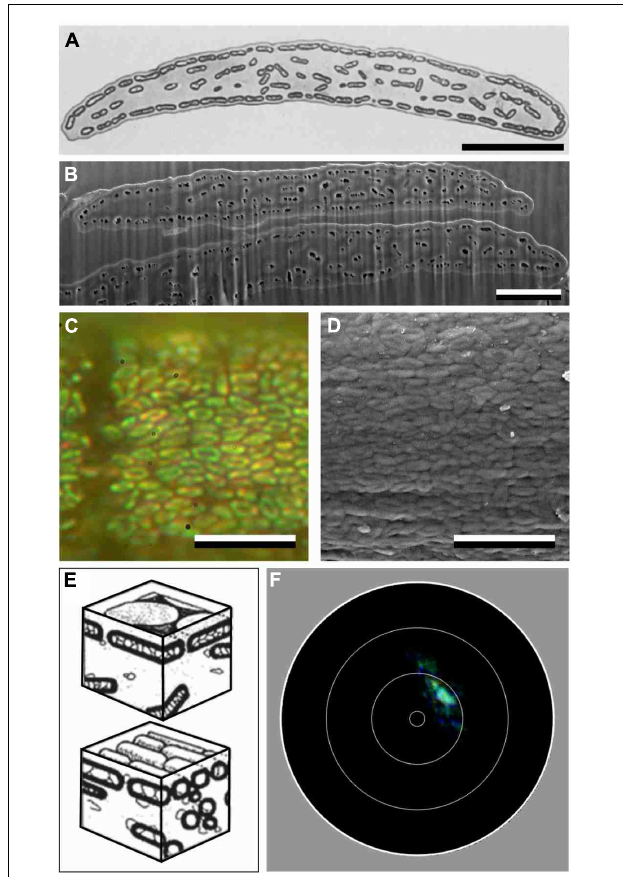
FIGURE 6 | Anatomy and scatterometry of a barbule of L. nitens . (A) Transmission electron micrograph (TEM) of a barbule cross-section of the Superb starling, Lamprotornis superbus [modified after Durrer (1977)]. (B) Scanning electron micrograph (SEM) of a cross- section of two overlapping barbules of L. nitens . Note that the contrast between TEM and SEM is reversed: melanin is dark in (A) , but it is light in (B) , while the air holes of the melanosomes are light in (A) and dark in (B) . (C) Epi-illumination micrographs of a blue barbule of L. nitens in oil immersion. (D) Scanning electron micrograph of the surface of a L. nitens feather barbule. (E) Diagrams of the two types of hollow melanosomes encountered in Lamprotornis starlings [from Durrer (1977)]. (F) Imaging scatterogram of a green barbule of L. nitens . Scale bars: (A–D) 5 µ